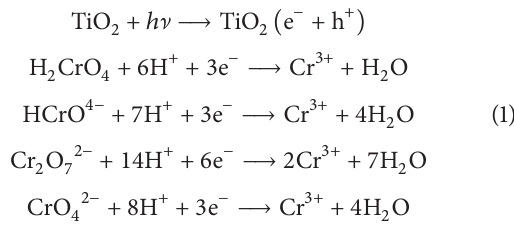
350 nm. Without a photocatalyst, K 2 Cr 2 O 7 is not degradable under the light irradiation using solar simulator (not shown here). With TiO 2 as a photocatalyst, however, TiO 2 can absorb photons with energy higher than its bandgap, causing electrons to jump across the bandgap into conduction